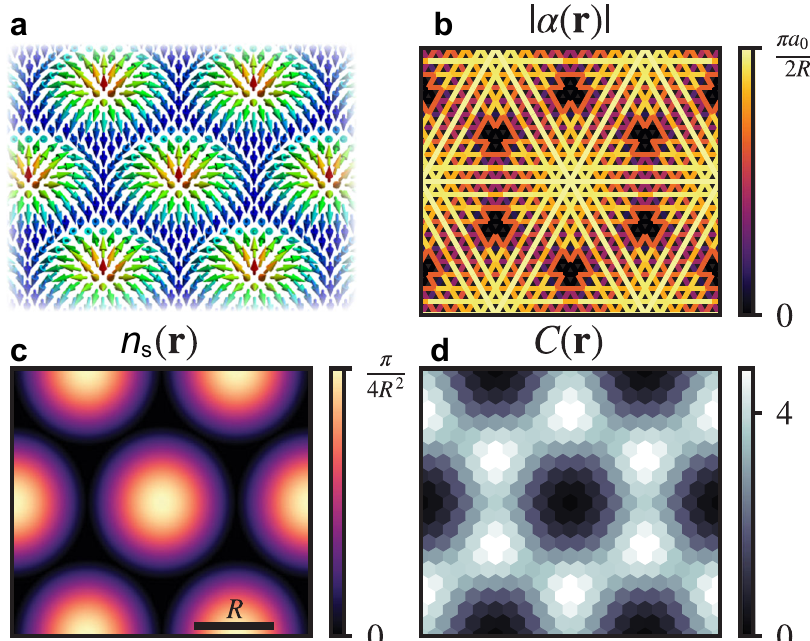
Fig. 1 MSH system with a magnetic skyrmion lattice. a Schematic picture of a skyrmion lattice. Spatial plot of b the magnitude of the induced Rashba spin – orbit interaction, ∣ α ( r ) ∣ , c the skyrmion number density, n s ( r ), and d the Chern number density C ( r ) for skyrmion radius R = 5 a 0 , and parameters ( μ , Δ , JS) = ( − 5, 0.4, 0.5) t